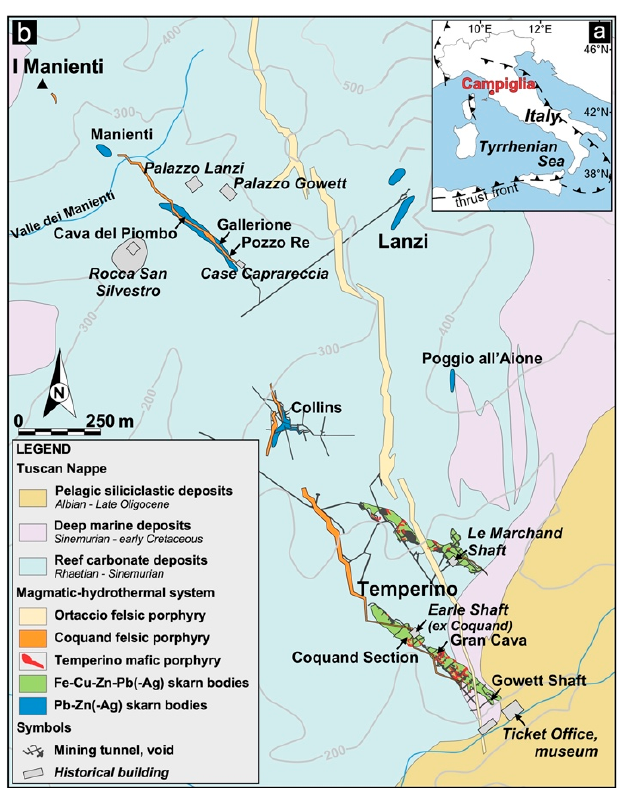
Figure 1. ( a ) Location of Campiglia in the northern Apennine chain. ( b ) Schematic geological map of Temperino–Lanzi area showing the main mining tunnels and historic buildings (e.g., Middle Age: Rocca San Silvestro ; Renaissance: Palazzo Lanzi , Case Caprareccia ; XIX-XX century: Palazzo Gowett , Earle, Le Marchand, and Gowett shafts).